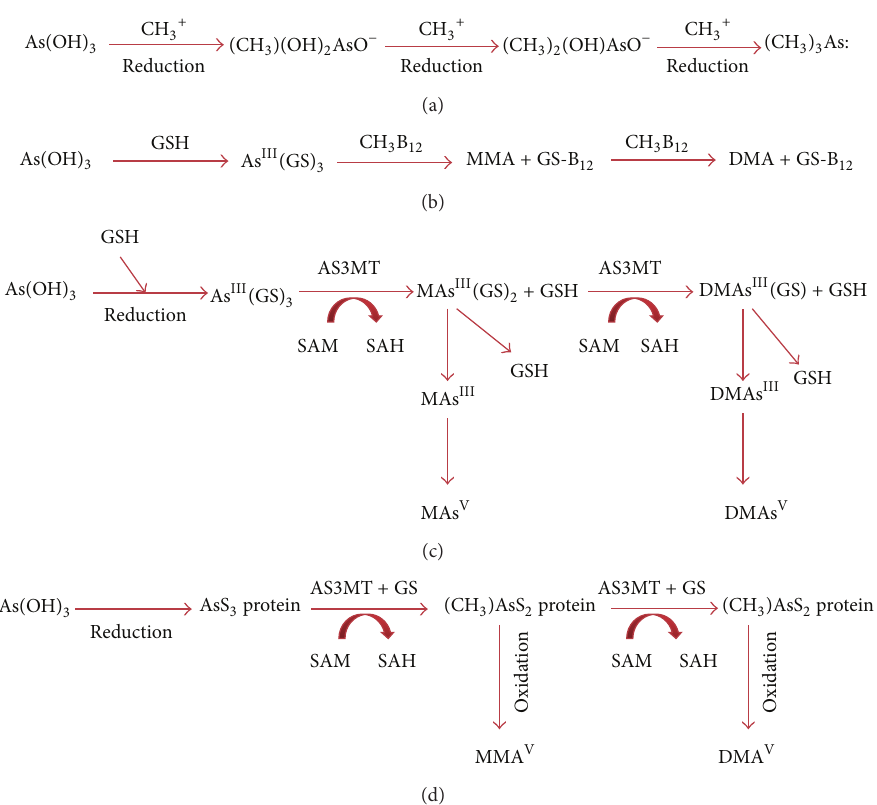
Figure 1: Pathways of arsenic metabolism in cells: (a) arsenic methylation in Scopulariopsis brevicaulis [54], (b) nonenzymatic As methylation in rat liver [55], (c) arsenic metabolic pathway in rat liver [56], and (d) metabolic pathway in rat liver [58], where SAM: S- adenosylmethionine; SAH: S-adenosylhomocysteine; CH 3+ : methyl group; GSH: glutathione; (CH 3 )(OH) 2 AsO − : monomethylarsonous acid; (CH 3 ) 2 (OH)AsO − : dimethylarsinic acid; (CH 3 ) 3 As: trimethyl arsine oxide; As (GS) 3 : arsenic triglutathione; MMA: monomethylarsonic acid; DMA: dimethylarsinic acid; MAs III (GS) 2 : monomethylarsonic diglutathione; DMAs III (GS): dimethylarsinic glutathione; DMAs III : trivalent